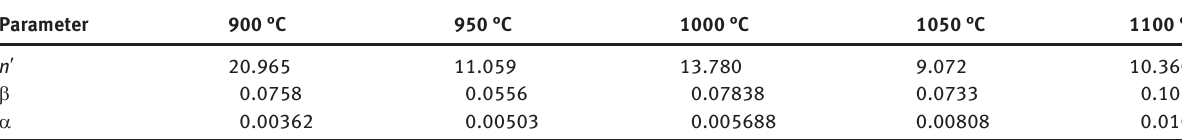
Table 3: ασ values under different deformation conditions Strain rate 900 °C 950 °C 1000 °C 1050 °C 1100 °C (s − 1 ) 0.01